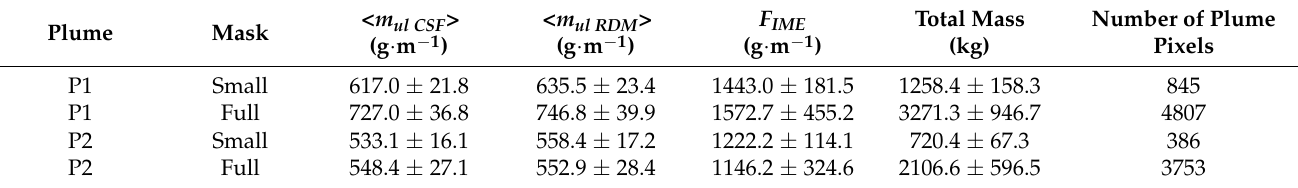
Table 4. Estimation of the wind normalized source flow rate corresponding to plumes P1 and P2 using ISBR-OEM retrieved concentration and CSF, RDM or IME flow rate estimation